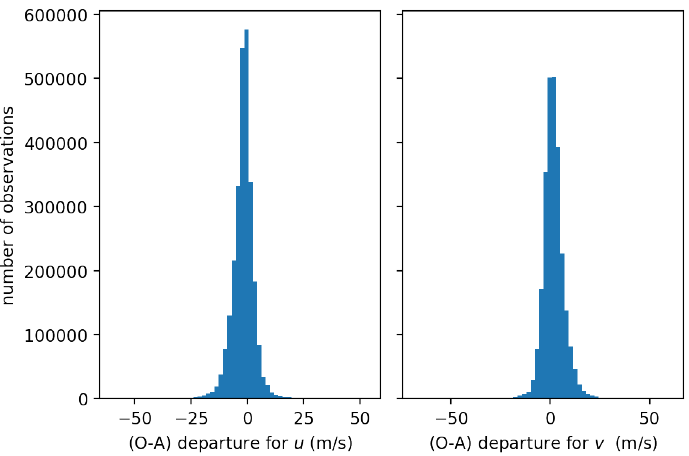
Figure 2. Distribution of (O-A) for zonal ( u , left ) and meridian ( v , right ) components of wind speed. Only values for u and v below 15 m · s − 1 are selected. Data are distributed in 60 bins.